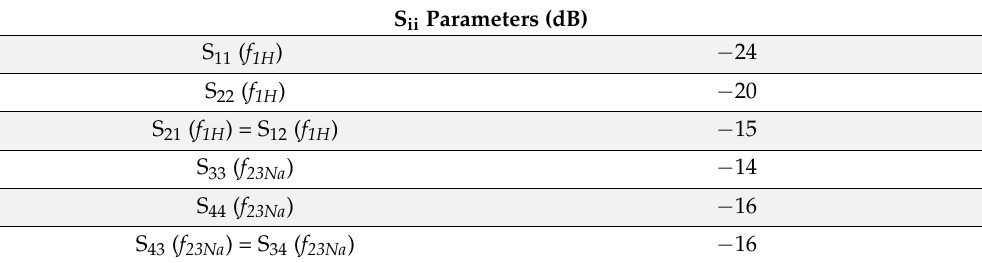
Table 5. Measured Sii parameters of the ‘four-rings’ DT-RF coil